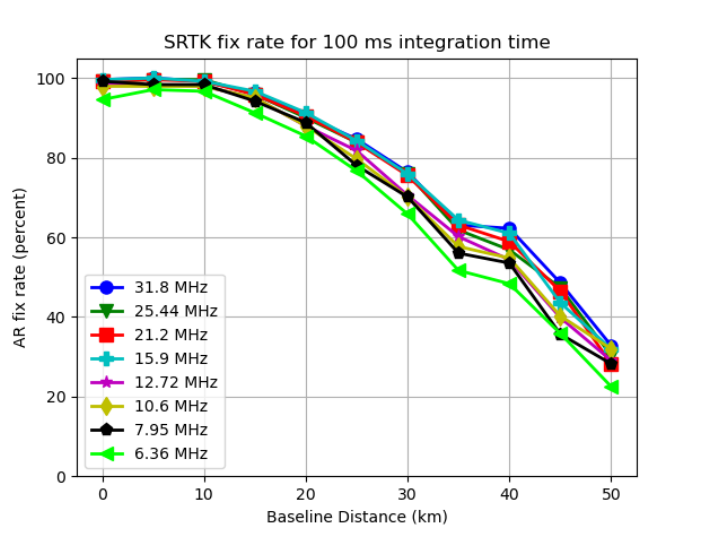
Figure 8. SRTK fix rate for different bandwidths when 100 ms integration time is used.